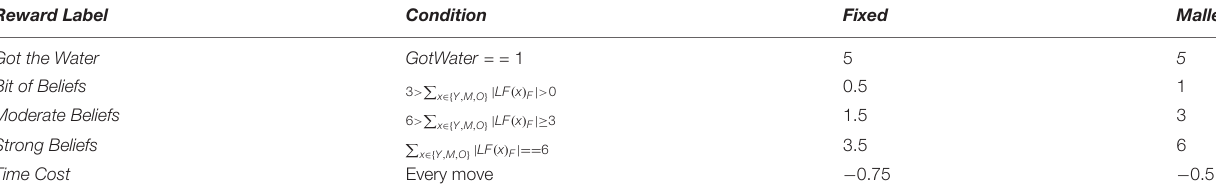
TABLE 4 | Reward values for different achieved conditions for the two mindset models. Reward Label